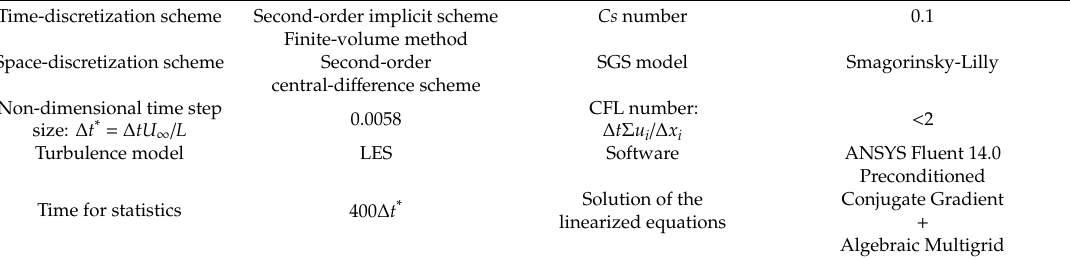
Table 4. Numerical schemes.